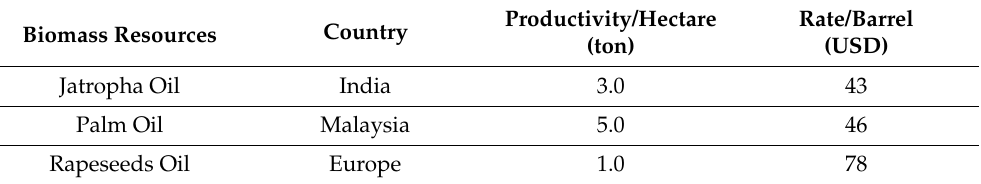
Table 11. Jatropha oil biodiesel production cost comparison with other oils